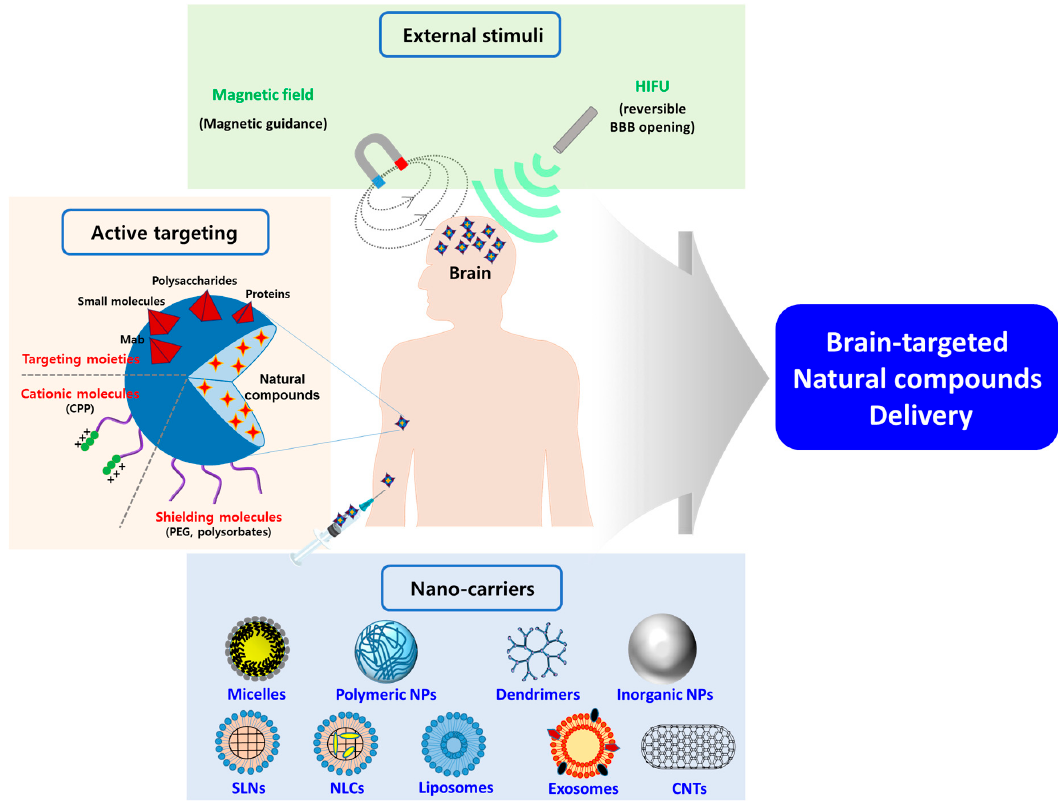
Figure 4. Schematic illustration of potential strategies using various nanocarriers for the enhanced brain delivery of natural compounds for treating neuroinflammation. Using various nanocarriers, surface functionalization with shielding moieties, cell-penetrating molecules, and targeting moieties, and applying external stimuli could be promising strategies for enhancing the delivery of natural compounds into the